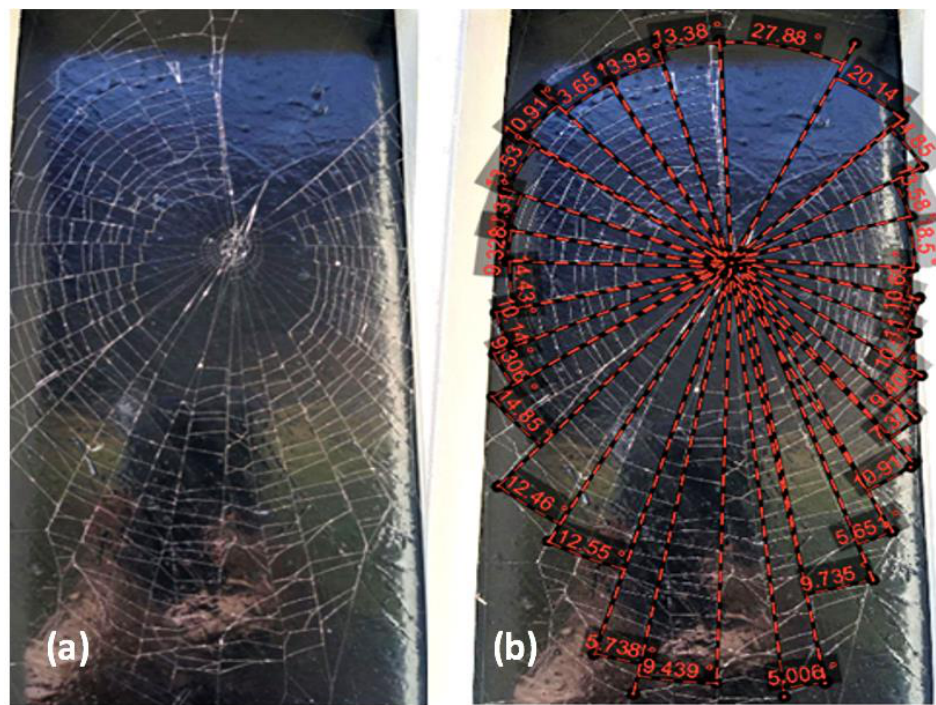
图 3 Figure 3. ( a ) Unmeasured image ( b ) measured image of